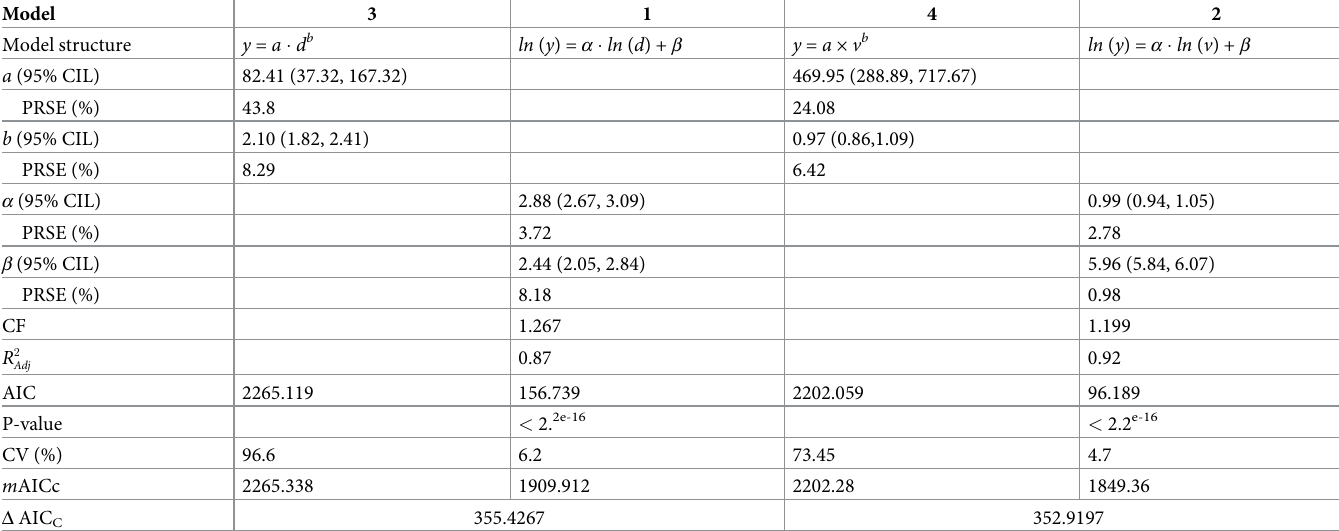
Table 2. Comparison of log-log linear and non-linear models for individual-tree aboveground biomass of cerrado sensustricto in Brazil. Model Model structure